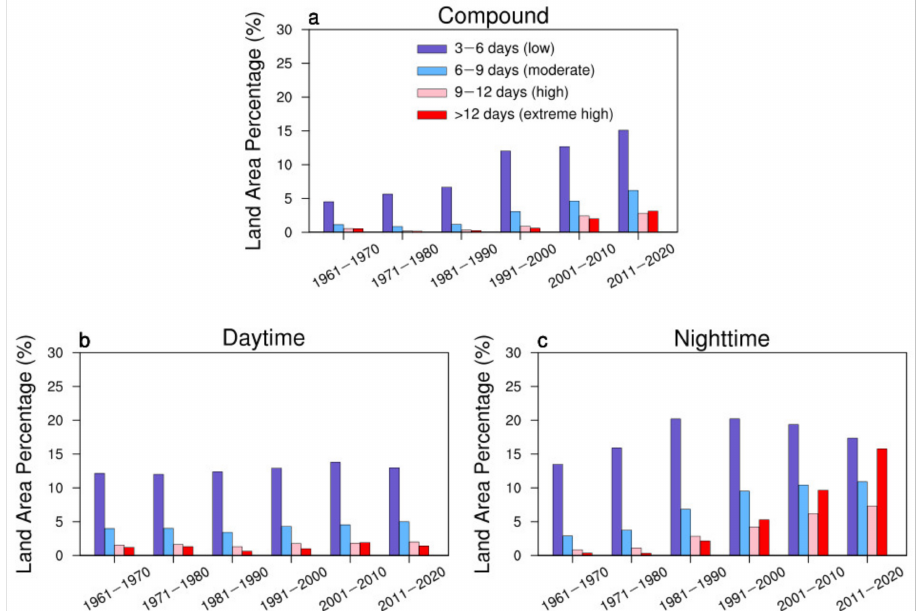
Figure 5. Temporal variations in proportion of land areas suffering wet ( a ) compound, ( b ) daytime and ( c ) nighttime HWs with HWF falling within a specified range, such as 3–6 days (purple), 6–9 days (blue), 9–12 days (pink) and >12 days (red). Results are averaged over each decade during